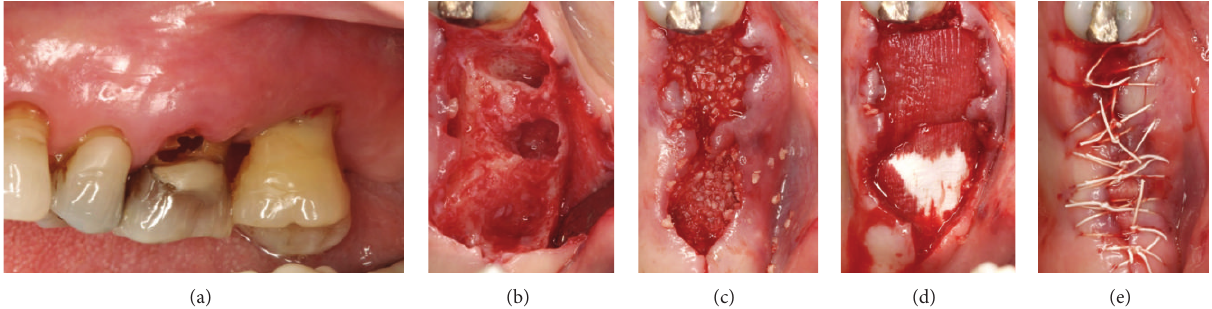
Figure 1:Clinical views ofCase 1. (a)Pretreatment and after (b) extractions, (c)bone graftplacement, (d)adaptation oftwo collagen matrices, and (e) suturing.